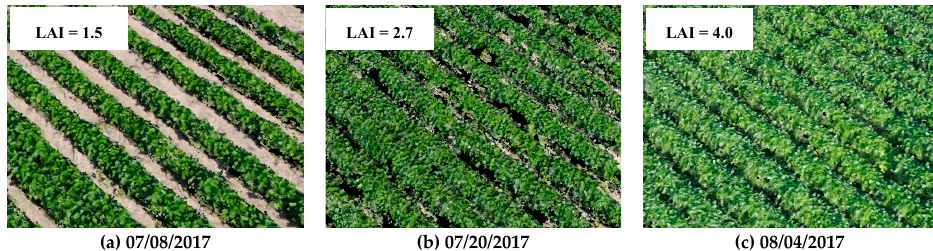
Figure 11. Three-dimensional view of photogrammetric point clouds derived from UAV RGB images at different development stages, including July 8 ( a ), July 20 ( b ), and August 4 ( c ) of 2017.